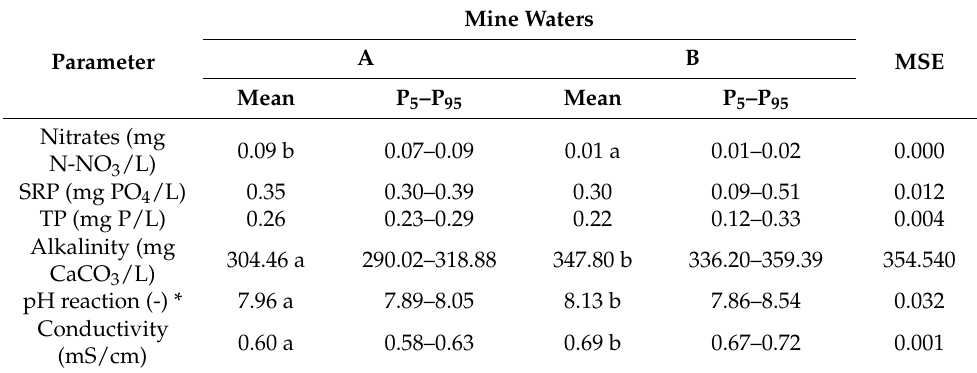
Table 1. Physicochemical characteristics of studied brown coal mine